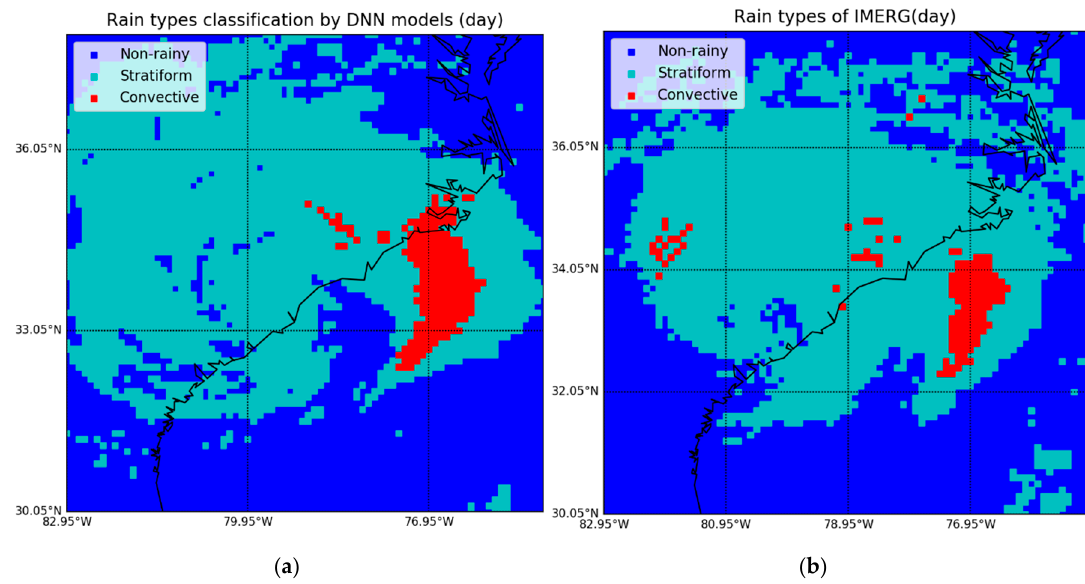
Figure 6. Cloud classification results and IMERG estimations of Hurricane Florence: ( a ) ABI; and ( b ) IMERG estimation on 15 September 2018, at 18:00–18:30 UTC.